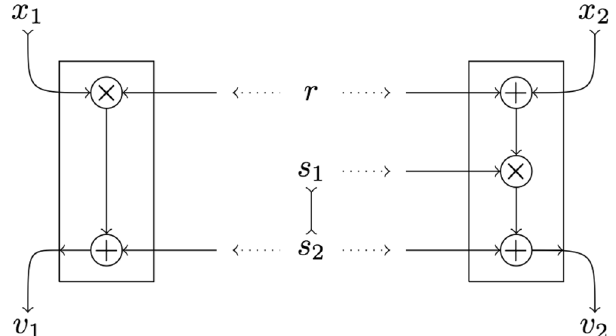
Figure 3. Stochastic process corresponding to the local box L , Eqs (16–20). The line connecting s 1 and s 2 is used to indicate they are not independently random, they are tight by (21).